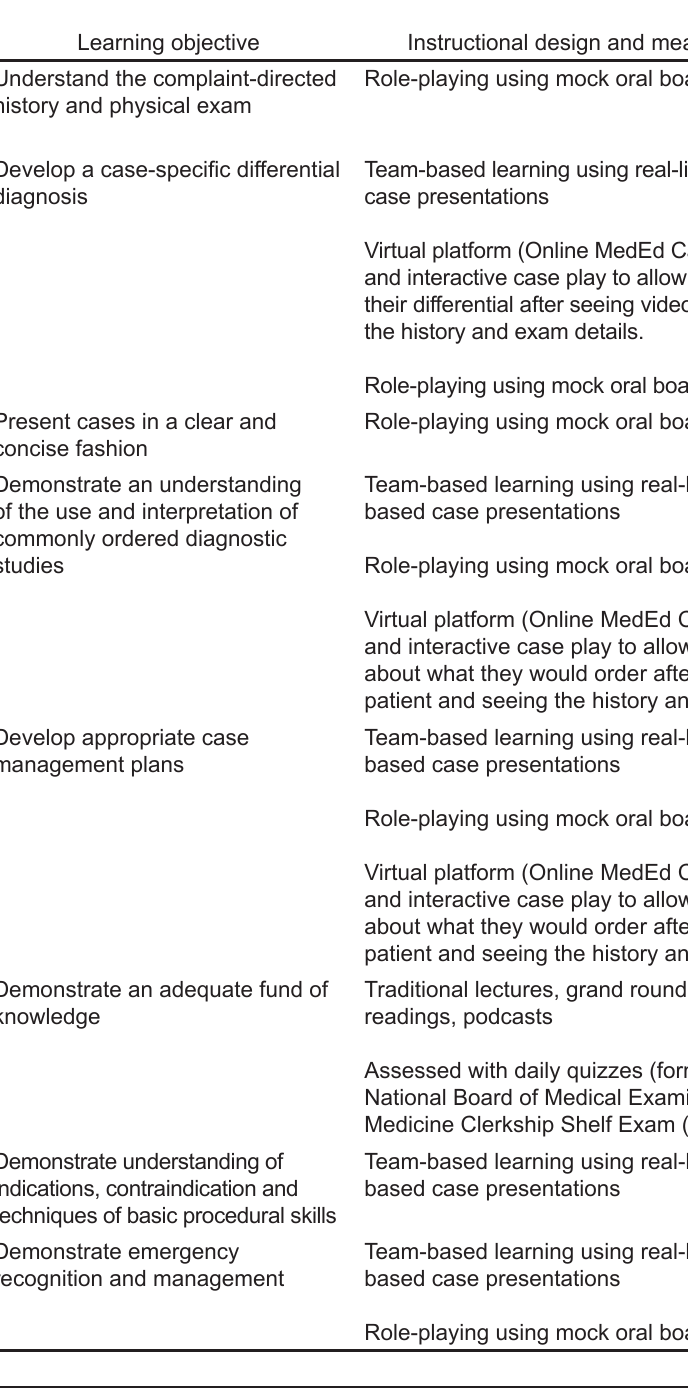
Table 1. Objectives, instructional methods, and assessment strategies for a virtual emergency medicine clerkship